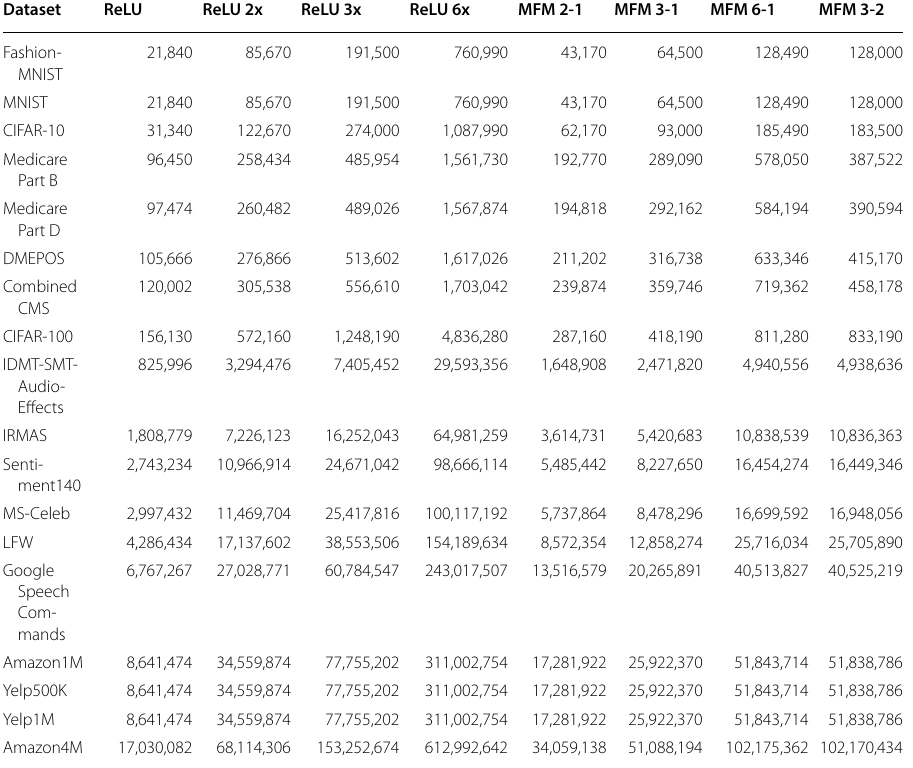
Table 3 Number of trainable parameters per dataset